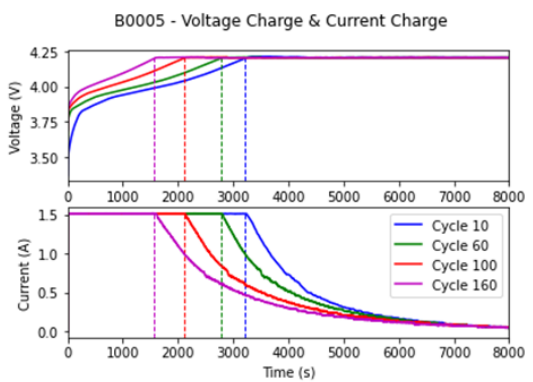
Batteries 2022 , 8 , x FOR PEER REVIEW Figure 2. The charge voltage and charge current curves for different cycles. Figure 2. The charge voltage and charge current curves for different cycles.